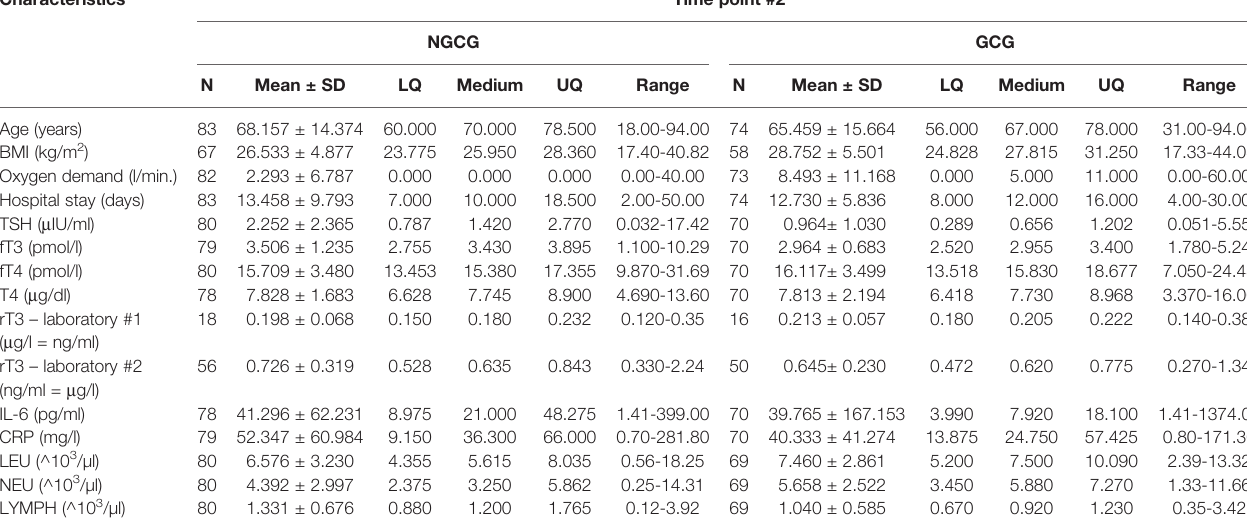
TABLE 4 | Chosen clinical and laboratory parameters – time point #2.